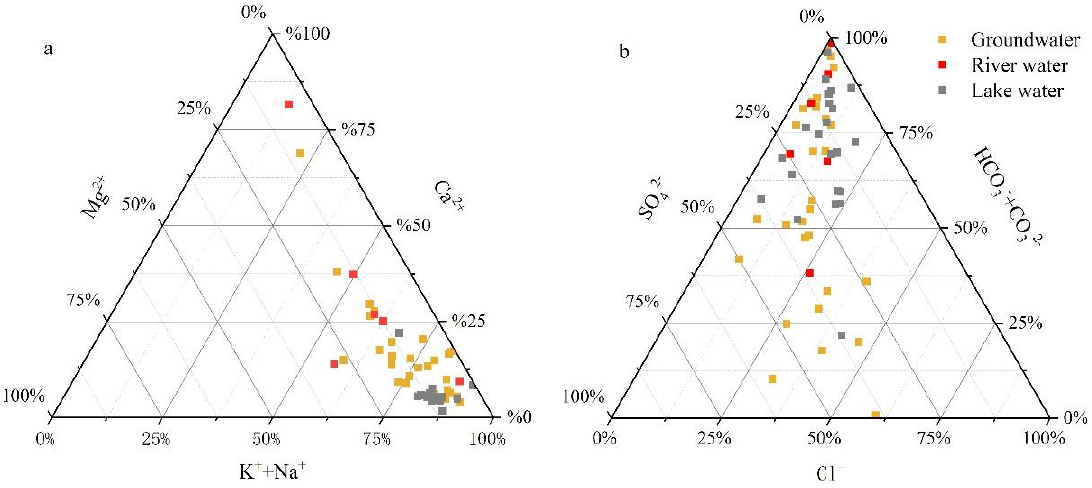
Figure 4. Cations ( a ) and anions ( b ) diagram for the water in the Hulun Lake regime.